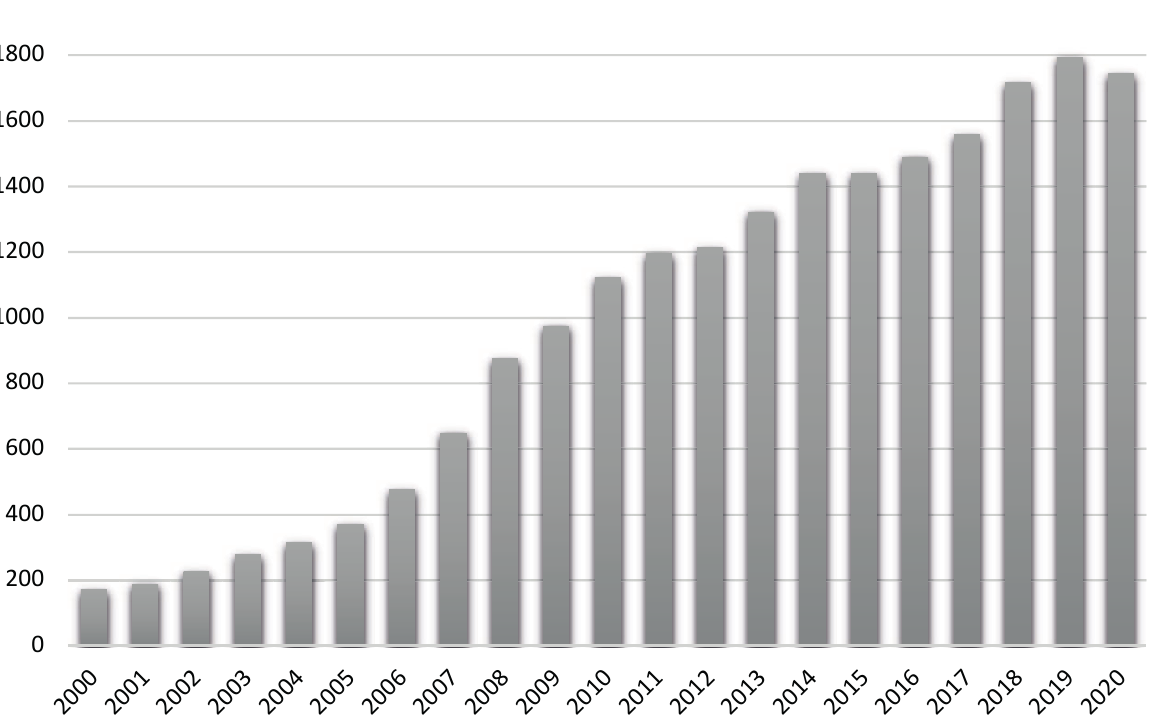
Figure 1. Biofuel production worldwide from 2000 to 2021(in 1,000 barrels of oil equivalent per day). Source: Own elaboration based on statista.com.